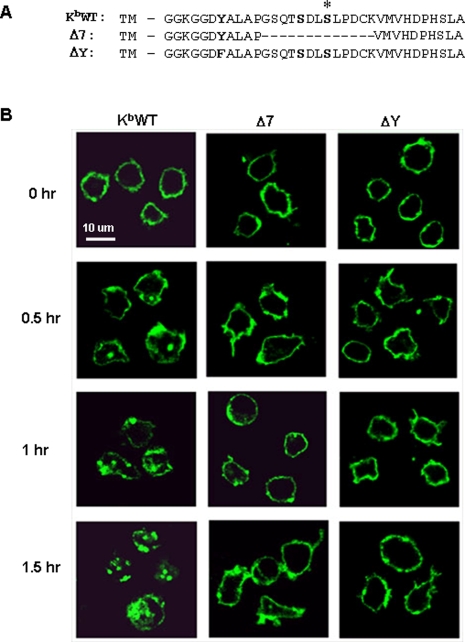
Constitutive MHC-I internalization in DCs is differentially controlled by cytoplasmic tyrosine- and exon 7-dependent mechanisms.(A) Amino acid sequences of the cytoplasmic domains of wild-type H-2Kb and the two cytoplasmic tail mutants Δ7 and ΔY. The asterisk denotes a known conserved serine phosphorylation site. The Δ7 mutant contains a deletion of the 13 amino acids comprising exon 7, indicated as dashed lines. Highlighted amino acids indicate conserved tyrosine and serine residues. TM, transmembrane domain. (B) Splenic dendritic cells isolated from KbWT, and Δ7 and ΔY transgenic mice were labeled with FITC-conjugated H-2Kb-specific mAb, washed, and incubated at 37°C for the indicated time points. DCs were then imaged using confocal fluorescence microscopy to visualize internalized MHC-I-containing vesicles. Data are representative of at least 3 images captured from 2 independent experiments.